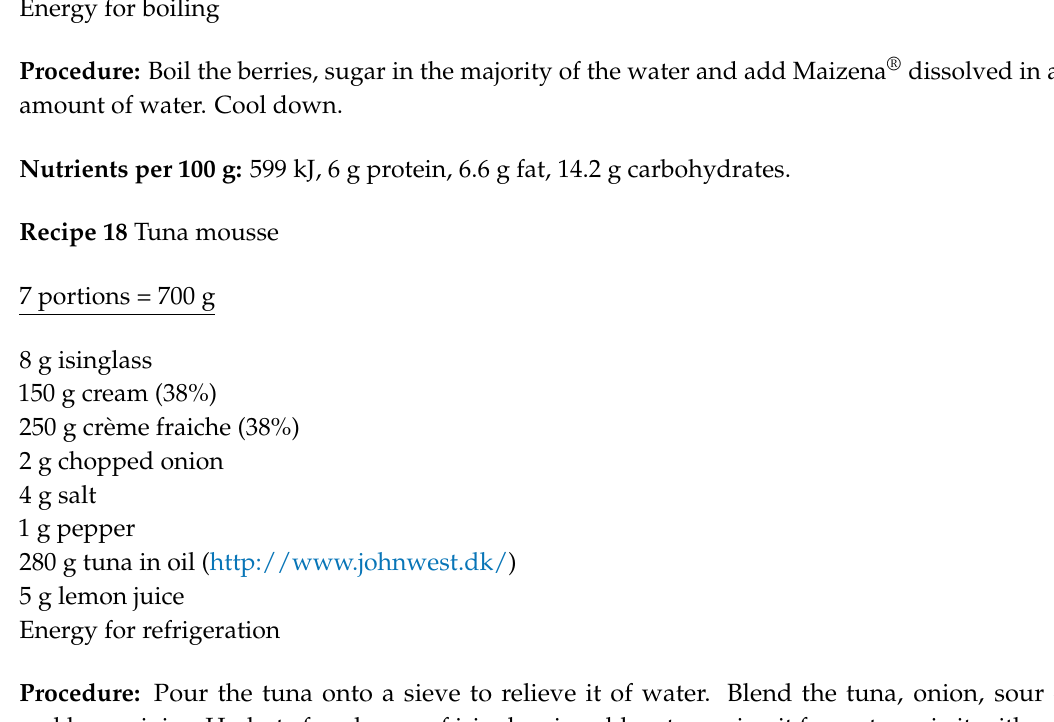
Procedure: Boil the berries, sugar in the majority of the water and add Maizena ® dissolved in a small amount of water. Cool down.